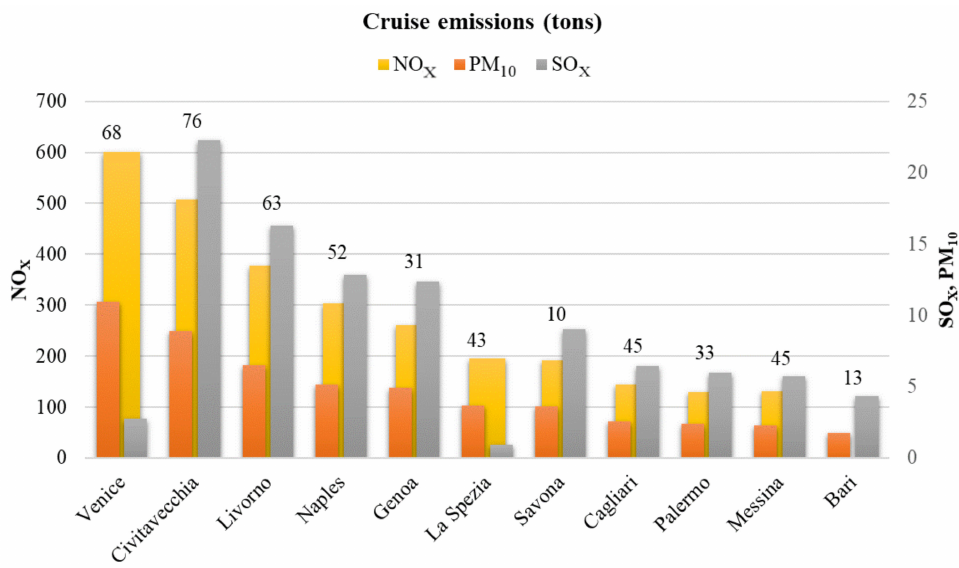
Figure 5. Cruise emissions in the main harbours in Italy. Number of ships is also reported for each site. Adapted data from [12].